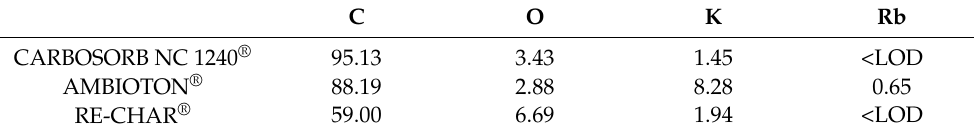
Table 6. EDS analysis of the three carbon-based sorbents (elements in weight % 1 ).